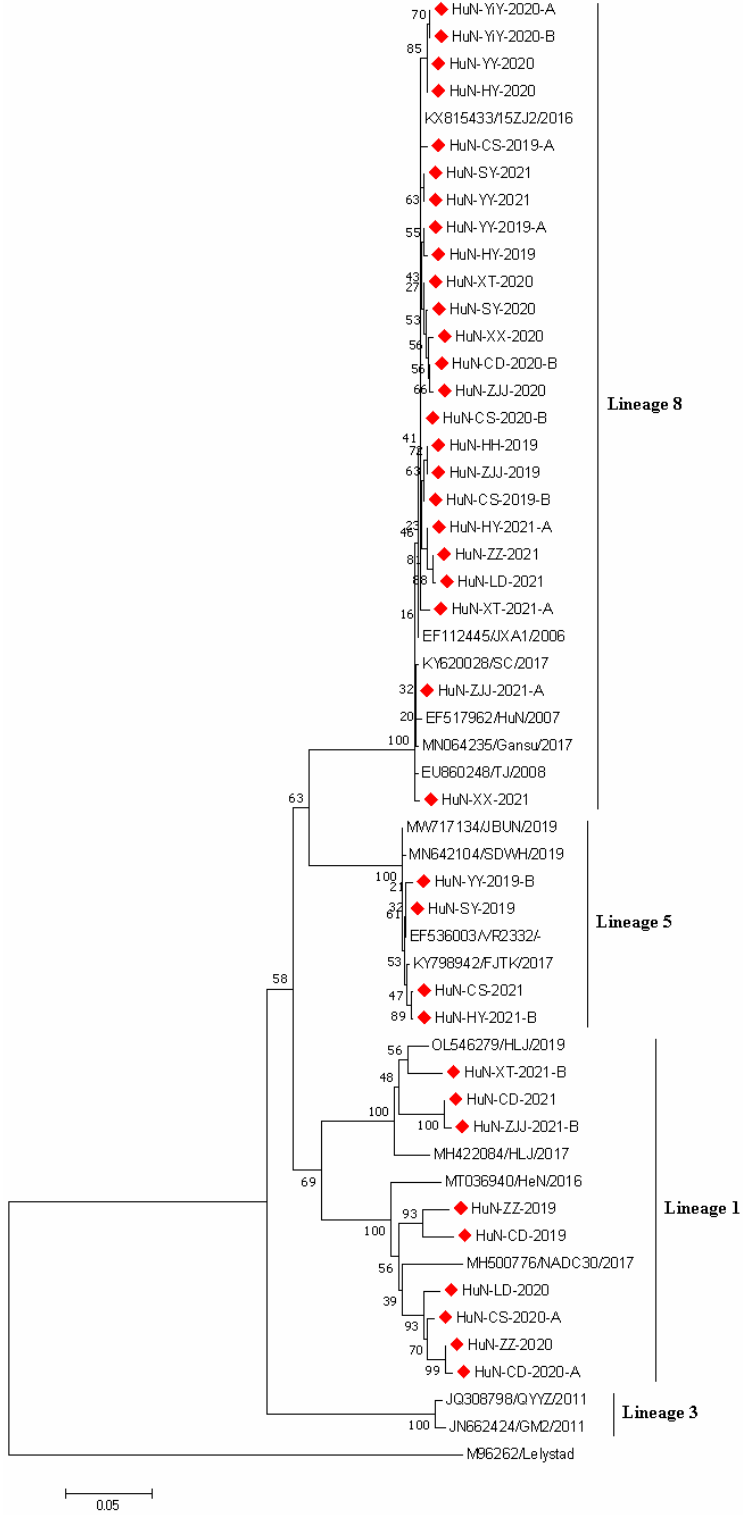
Figure 1. Phylogenetic tree based on ORF5 gene sequences of 37 PRRSV strains identified in this study and other reference strains generated by the neighbor-joining method in MEGA 7.0 software, with 1000 bootstrap support. The red prismatics represent these newly identified PRRSV strains.